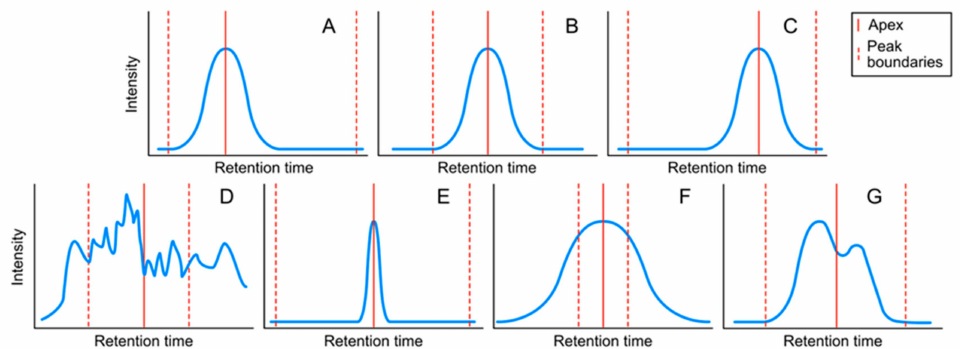
Figure 4. Schematic representation of the seven peak classes defined in WiPP. For clarity purposes, only one m / z is represented here. ( A ) Apex shifted to the left. ( B ) Centred apex. ( C ) Apex shifted to the right. ( D ) Noise. ( E ) Peak with wide margins to window borders. ( F ) Peak exceeds window borders. ( G ) Merged / shoulder peak.